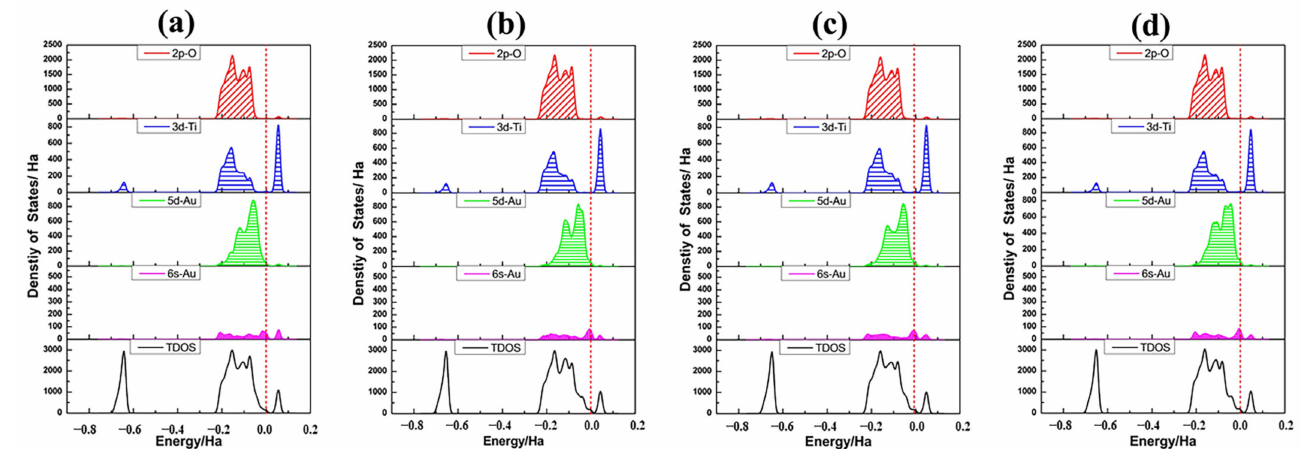
Figure 7. Density of state profiles and the partial density of states of Au 8 and relevant nanotube sur- face atoms for Au 8 clusters in four different adsorption states: ( a ) Au 8-A(2cO,3cO,2cO) ; ( b ) Au 8-B(2cO,5cTi) ;